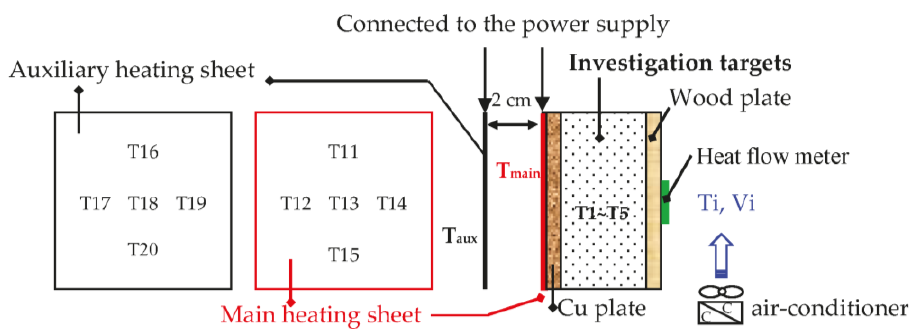
Figure 3. Experimental test cell (T x : thermocouple locations) (not to scale).